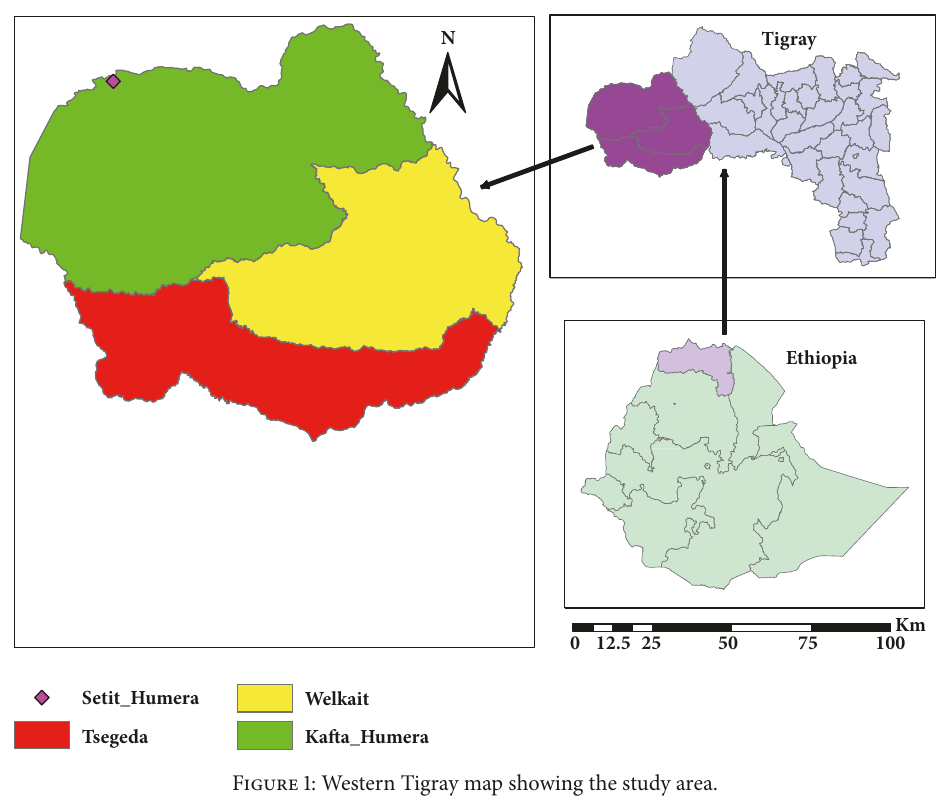
Figure 1: Western Tigray map showing the study area.